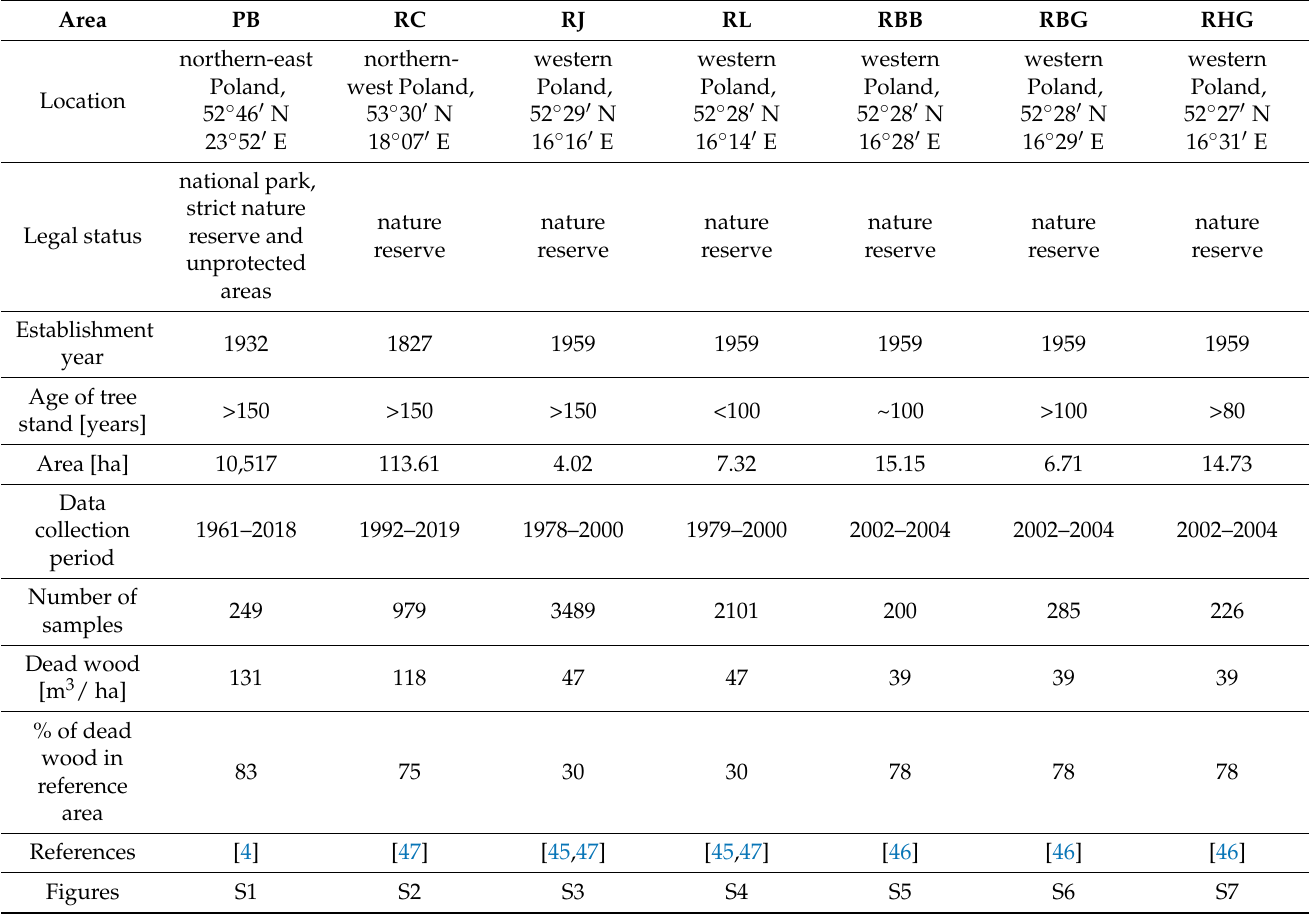
Table 1. Location, legal status, and number of collected samples in the examined areas. PB—Białowie˙za Primeval Forest, RC—Cisy Staropolskie im. Leona Wycz ó łkowskiego Nature Reserve, RJ—Jakubowo Nature Reserve, RL—Las Gr ˛adowy nad Mogilnic ˛a Nature Reserve, RBB—Byty´nskie Brz˛eki Nature Reserve, RBG—Brz˛eki przy Starej Gaj ó wce Nature Reserve, RHG—Huby Grzebieniskie Nature